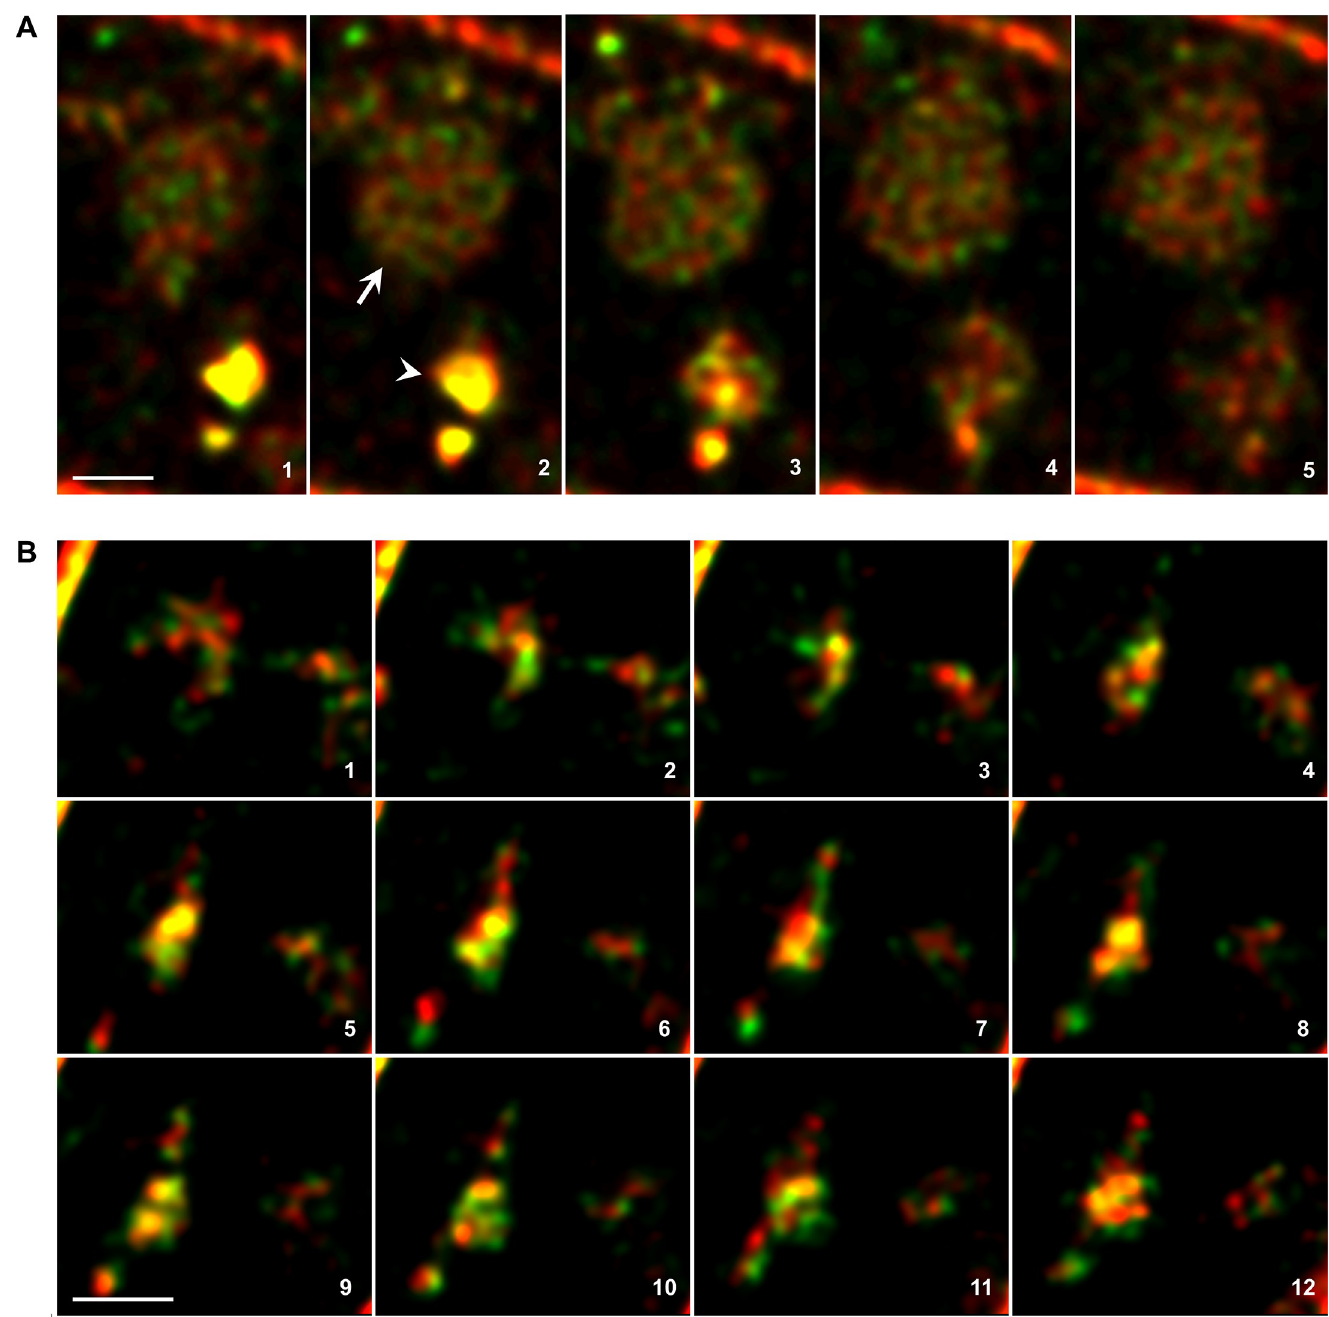
Fig 2. Newly synthesized and internalized PIN2 populations appear in ES2As and vacuoles. In the photoconversion experiment, vacuoles (arrow) and ES2As (arrowhead in A) are detectable in both green and red channels. Note that the green and red signals were partly overlain in large ES2As (yellow color). B shows detailed images of the cytoplasm area with green and red separated patches. These merge into larger aggregates where the signals partly overlap (yellow color). In this experiment, roots were photoconverted, then seedlings were placed on the medium with 50 μ M ES2 for 1.5 hours and imaged with a Leica TCS SP8 STED 3X microscope. The numbers in the merged images combining red and green channels indicate optical slices’ order in the Z-stack. Bars = 1 μ m. https://doi.org/10.1371/journal.pone.0237448.g002 construct [15]. Herein, detected ES2As labeled by the red PIN2 variety, but the green PIN2- Dendra2 population was absent in these aggregates and the PM (Fig 3A and 3B). In the